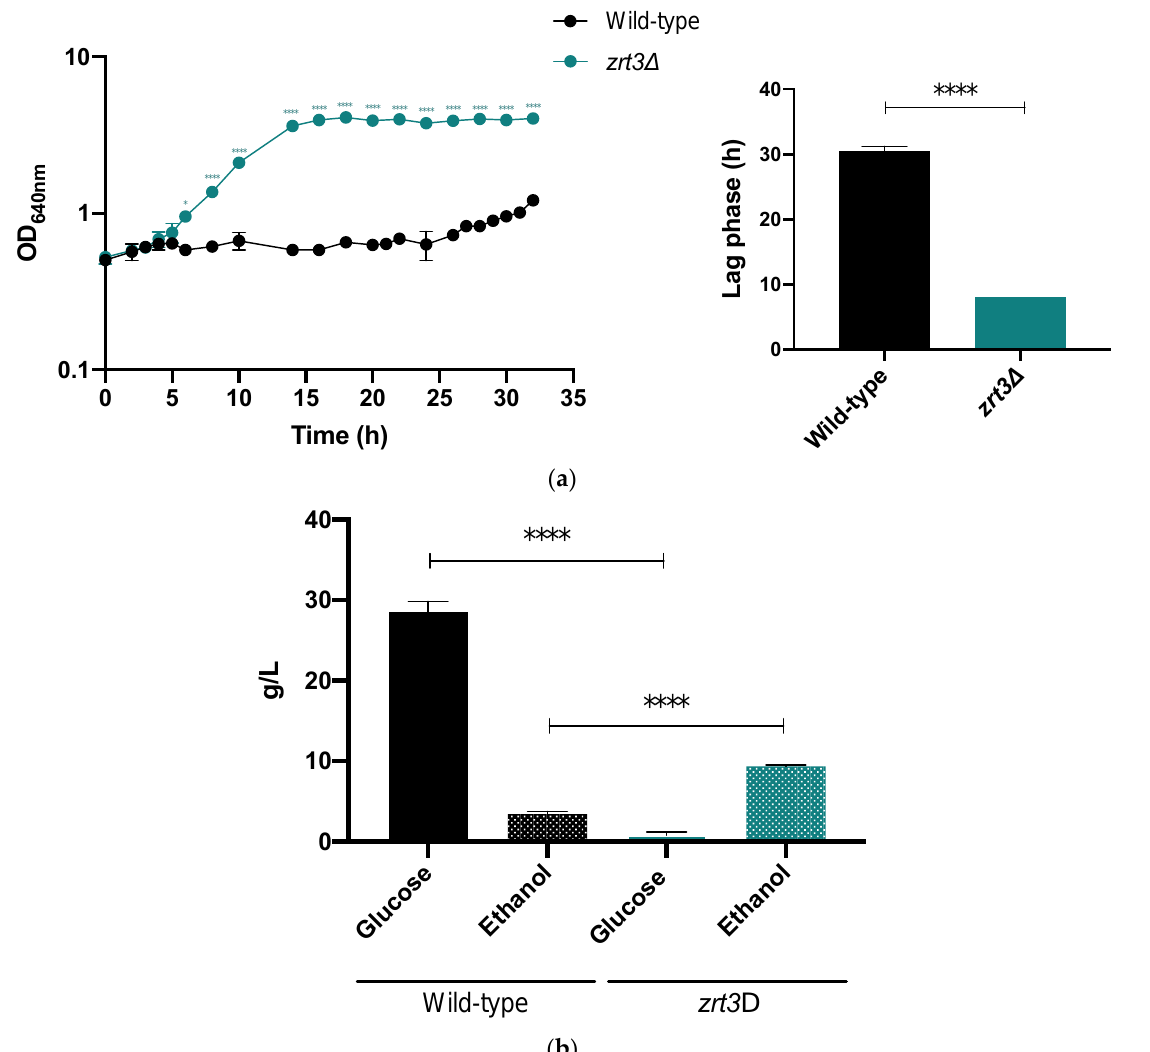
Figure 5. Effect of AA on cell growth and ethanol production of S. cerevisiae BY4741 wild-type and zrt3 Δ strains. ( a ) Cell growth in YEPD medium with 60 mM AA at pH 4.5. Insert: values of the lag phase duration, determined by the time required to double the initial optical density. ( b ) Glucose and ethanol concentrations at the end of the growth experiment (32 h). The values are the mean ± SEM (n = 2). Statistical analysis was performed by two-way ANOVA. * p < 0.05, **** p ˂ 0.0001 comparing the indicated conditions.